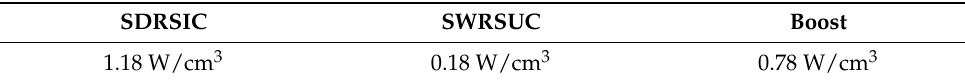
Table 2. The power density of the three